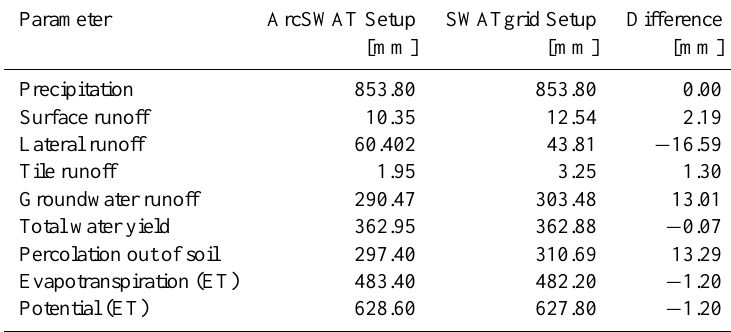
Table 2. Mean annual values of water balance components calculated by the two model setups. Parameter